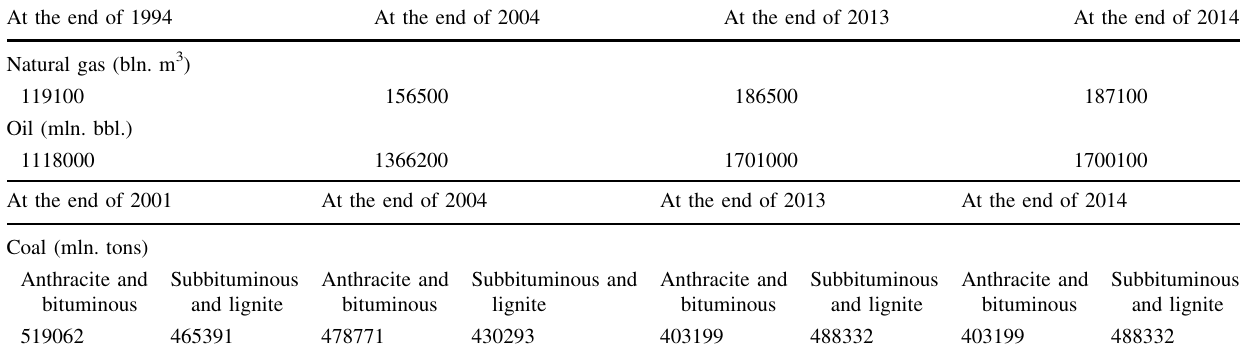
Table 1 Proven reserves of non-renewable energy sources in the world (Statistical Review of World Energy 2002, 2005, 2014, 2015; Inter- national Energy Outlook 2016) At the end of 1994